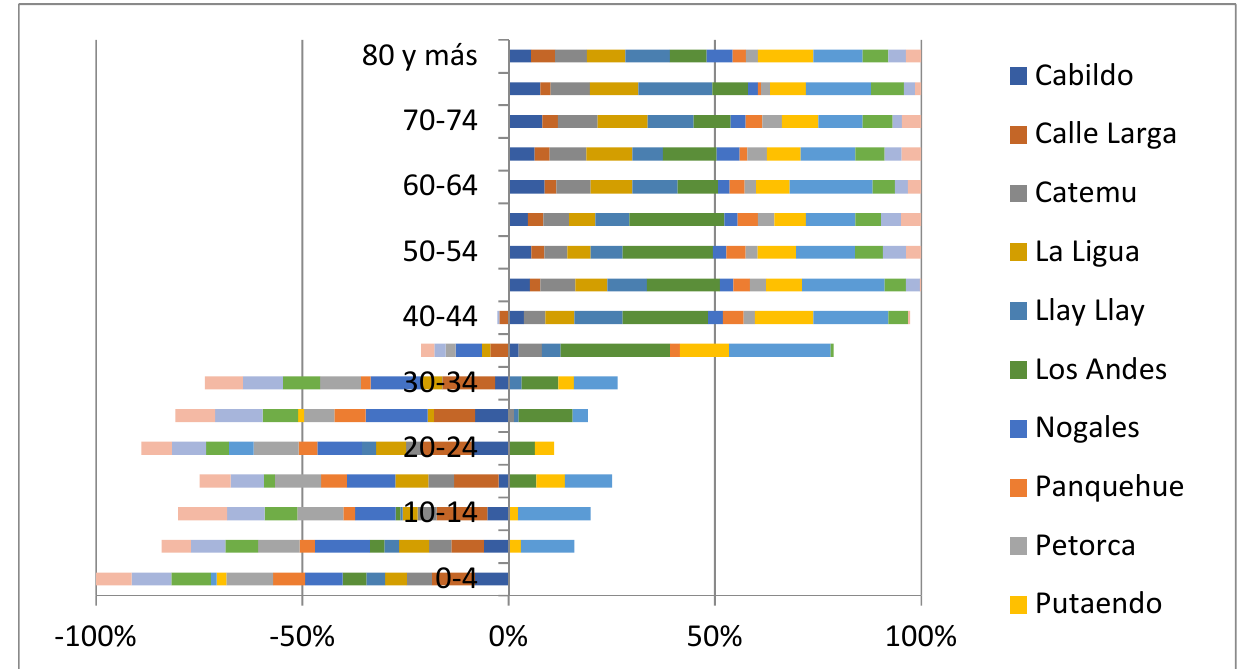
-100% Figure 6. Rural depopulation by five-year age groups, 1992–2017. Figure 6. Rural depopulation by five-year age groups, 1992–2017. Between 1992 and 2017, the age composition moved toward greater aging levels, which may have been triggered by a decrease in births and an increase in youth migra- tion (Figure 7). The cases of Catemu (68.84), La Ligua (92.81), Petorca (85.49), Putaendo (75.97), and San Esteban (75.98) stand out. Though this is accompanied by a